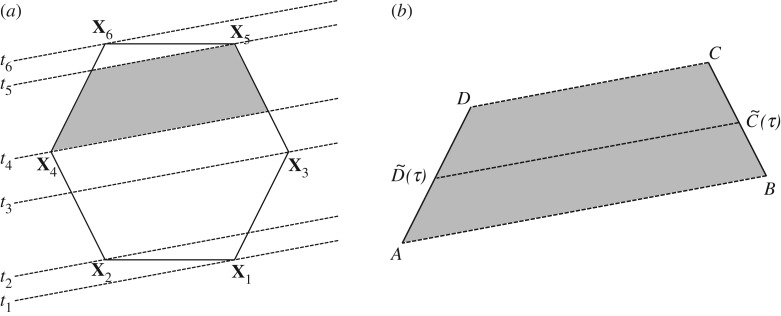
(a) Evolving face–interface intersection line drawn for each time it passes a vertex (dashed lines). An example of the area swept between two such times is marked (grey quadrilateral). (b) Auxiliary notation for calculation of the face–interface intersection line at intermediate times.